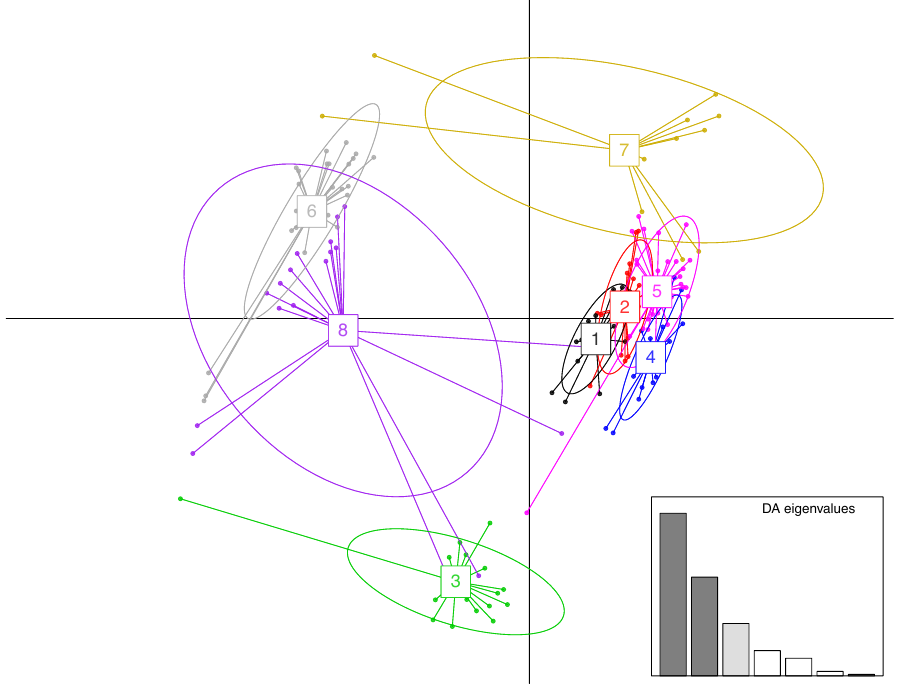
Figure 2. Discriminant Analysis of Principle Components (DAPC) scatterplot of the 8 major histocompatibility complex (MHC) supertypes identified here. 10 principle components (PC) and three discriminant functions (dimensions) were used to describe the relationship between the clusters. The scatterplot show only the first two discriminant functions ( d = 2). The bottom graph displays the barplot of eigenvalues for the discriminant analysis (DA). Dark grey, light grey and white bars indicate eigenvalues that were used in the scatterplot, not used in the scatterplot but retained for the analysis, and not retained for the analysis, respectively. Each allele is represented as a dot, and the supertypes as